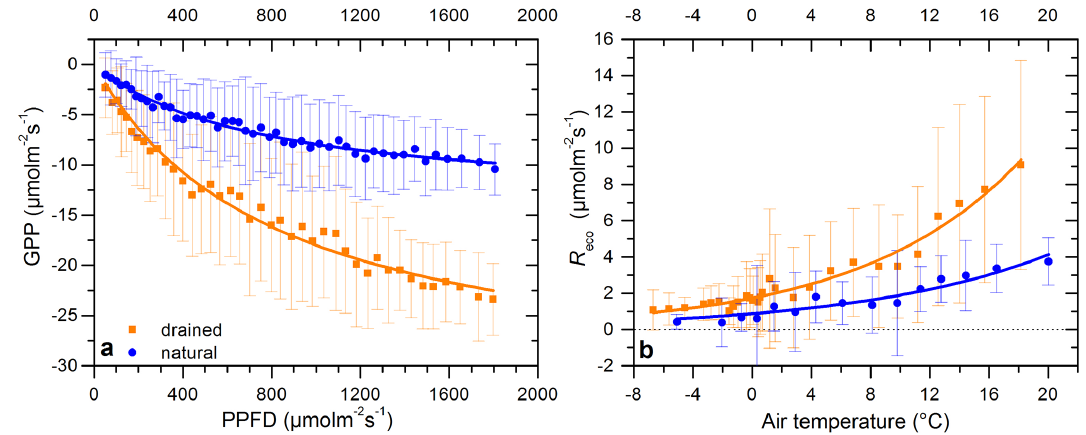
Figure 4. (a) GPP (daytime fluxes − R eco ) versus PPFD; (b) ecosystem respiration ( R eco , nighttime fluxes) versus air temperature. Each point is the average of 100 non-gap-filled half-hourly measurements. The bars denote the standard deviations. Plots show binned data from the whole year 2011. Air temperature and PPFD were measured at the top of each tower (6m at the natural site and 30m at the drained site).